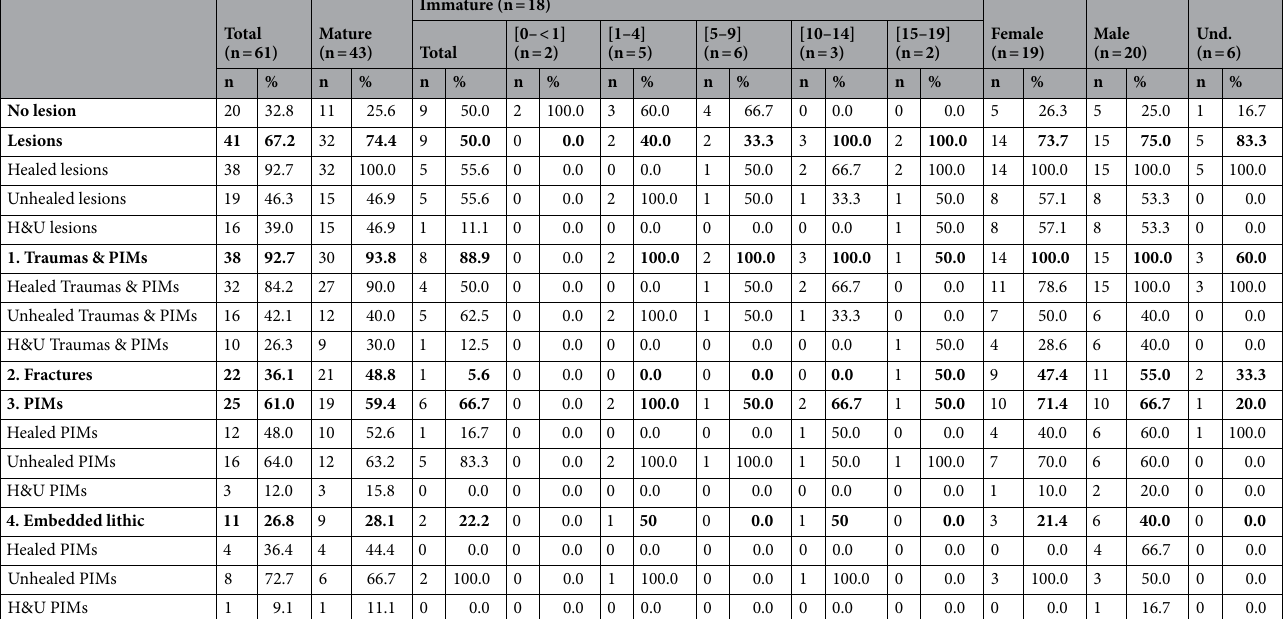
Table 1. Number of individuals exhibiting at least one type of lesion grouped by age-at-death or sexual diagnosis. The percentage in the two first lines are calculated on the minimal number of individuals for each category, while the percentage in the numbered bold lines are computed based on the recorded number of individual with lesions for each category. The percentage in the underlying lines represents the proportion of individuals with healed, unhealed and healed and unhealed lesion occurrence within the numbered line category. n = number; % = percentage; PIM = Projectile Impact Mark; H&U = Healed and Unhealed. Und. = mature individuals whose sexual diagnosis is